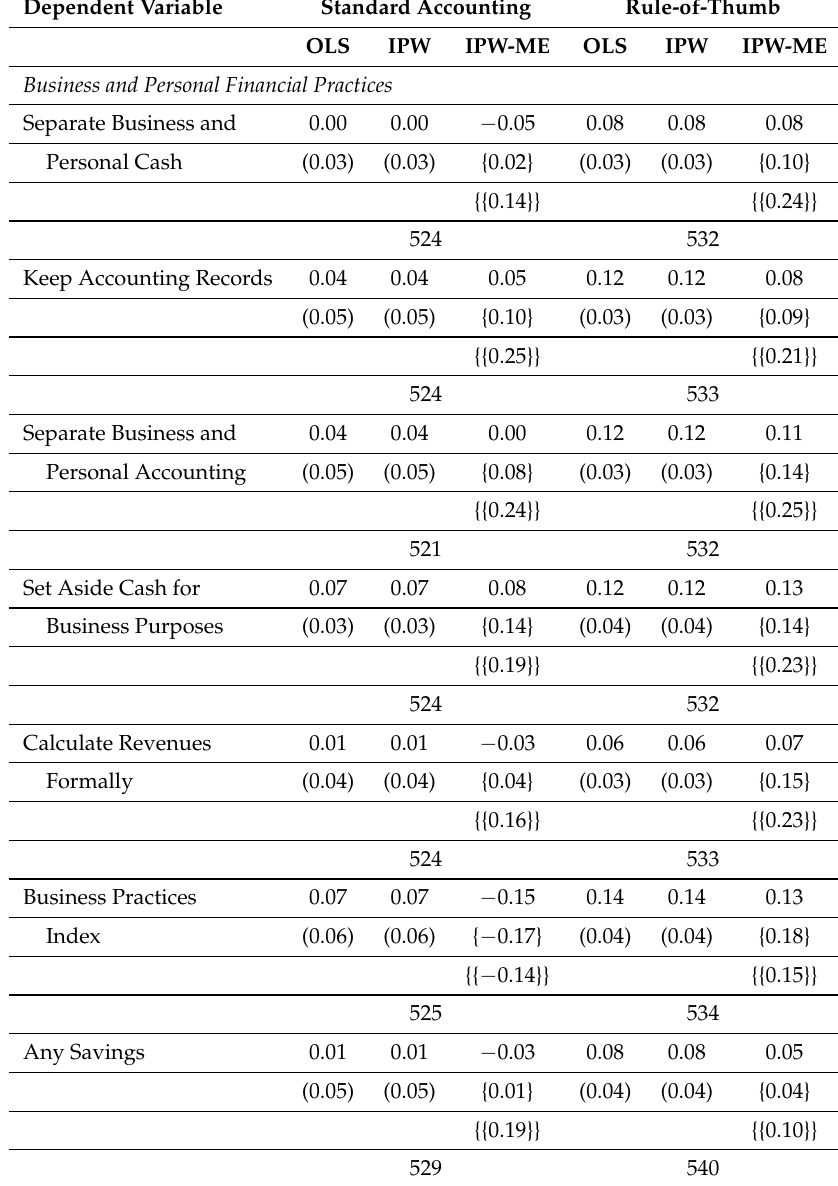
Table 4. Impact of Training on Business Practices and